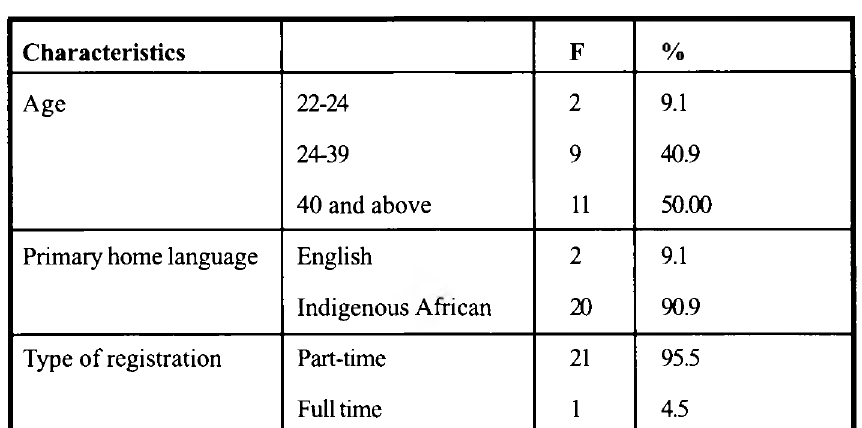
Table 1: Characteristics of the study population